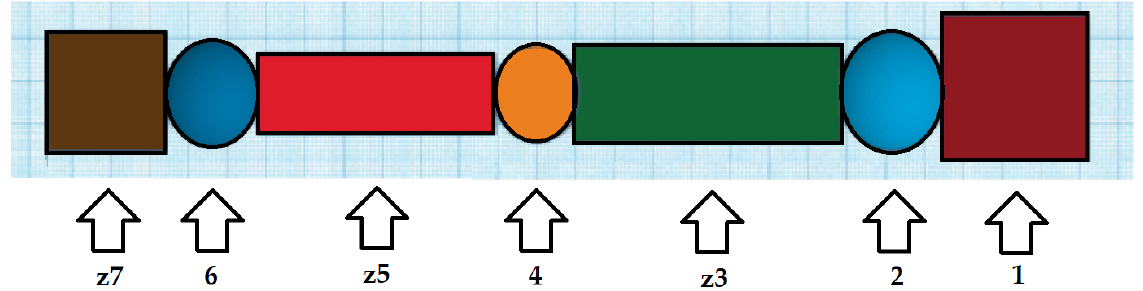
Figure 7. Exoskeleton project (1-Shoulder girdle; 2-scapular joint; z3-replacement arm; 4- elbow joint; z5-replacement forearm; 6 wrist joint; z7-replacement hand).